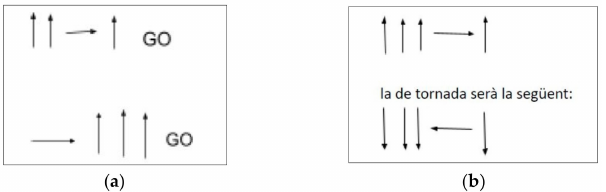
Figure 3. ( a ) Representation of group B3 to explain that the robot arrives at the same destination from different routes. ( b ) Representation of group B3 to explain the way to and from the destination running by the robot. In the image, you can read “the way back is the following”.